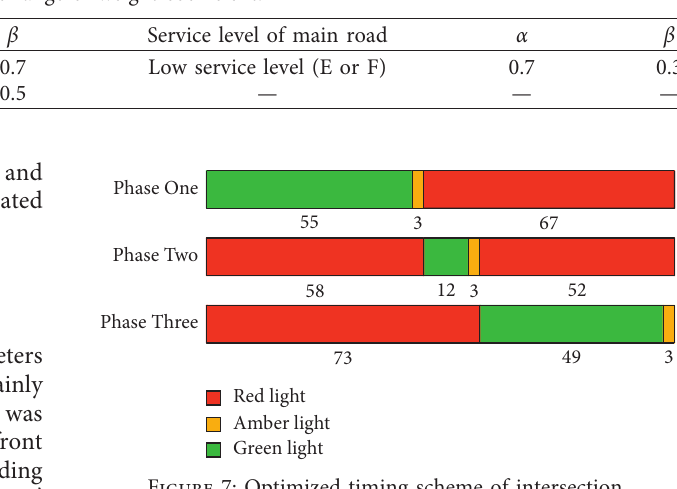
Table 6: Value range of weight coefficient.